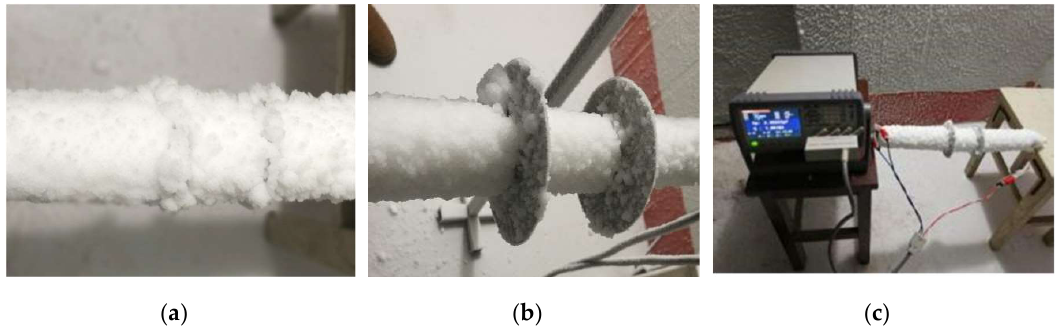
Figure 6. The photos of the different icing sample: ( a ) Soft rime of 24 mm thickness; ( b ) hard rime of 8 mm thickness; and ( c ) measurement of the relative dielectric 8 mm thickness; and ( c ) measurement of the relative dielectric constant.